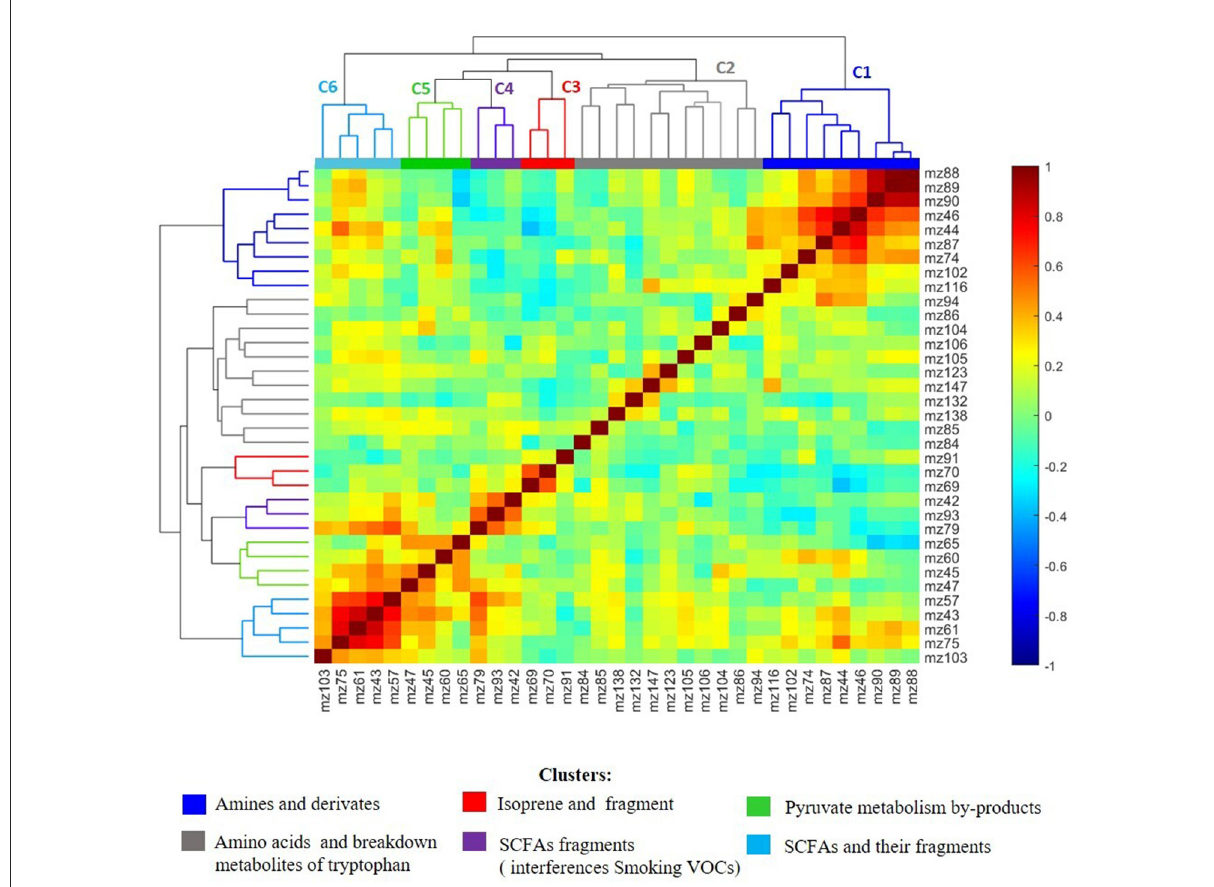
FIGURE2 Heatmap visualization and hierarchical clustering analysis of Pearson’s distance between significant altered breath metabolites of MDD patients compared to healthy controls ( p < 0.05) from awakening to 60min after awakening. The HCA showed the presence of six clusters of breath metabolites in which the member VOCs showed statistically significant correlation among each other in their perturbation from baseline to 60min after awakening. The clusters are primarily predominated with the same chemical class or metabolites involved in the same pathway/network. The cluster C1 (dark blue) contained mainly amines, C2 (gray) amino acids and breakdown metabolites of amino acid tryptophan, C3 (red) isoprene and its fragment at m/z = 70, C4 (violet) fragments of SCFA that are overlapped with aromatic smoking VOCs, C5 (green) metabolites involved in pyruvate metabolism and C6 (light blue) included SCFAs and their fragments. The metabolites in C2 showed lower correlation with each other due to the intra- and inter-variability of amino acids in exhaled bread using